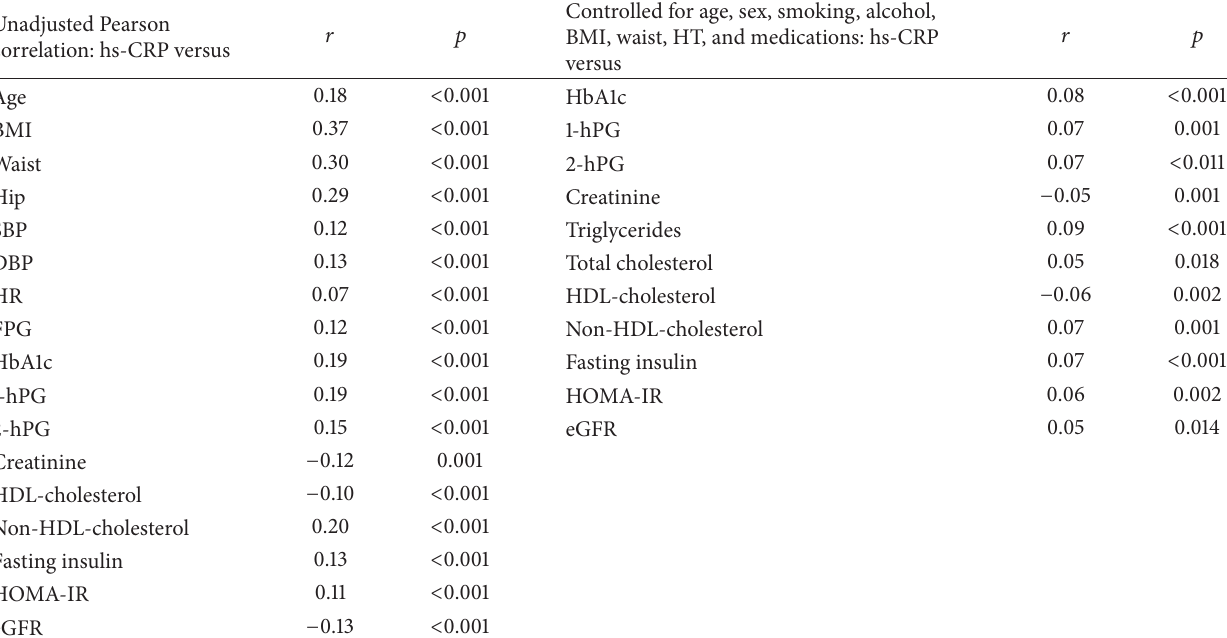
Table 2: Pearson correlation analysis (unadjusted and adjusted) of hs-CRP and other parameters. Unadjusted Pearson